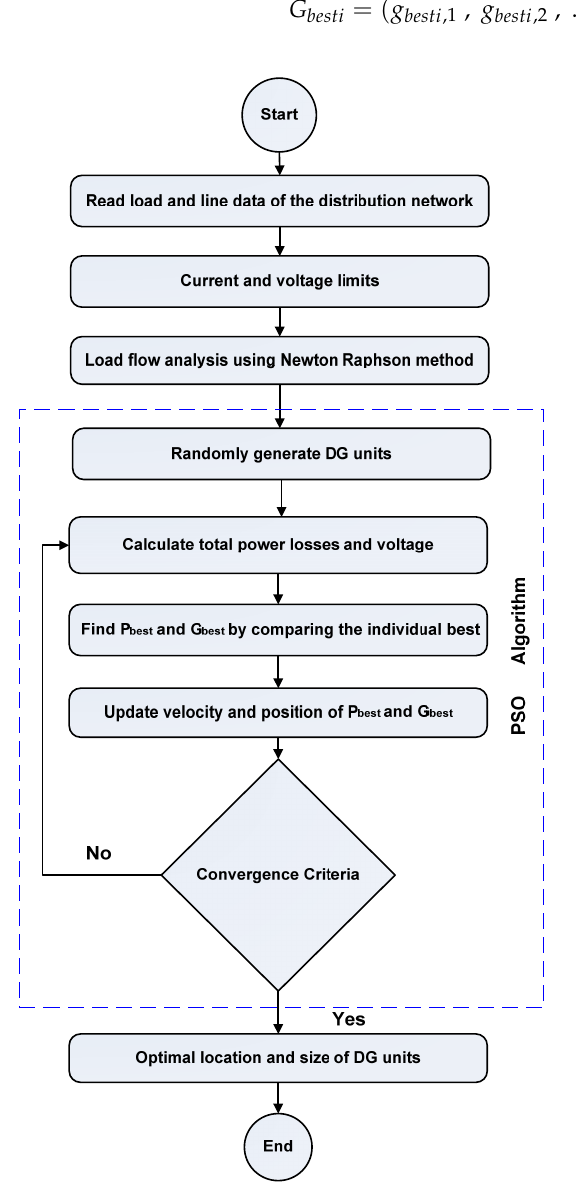
Figure 4. Flow chart of PSO algorithm for the distribution network.